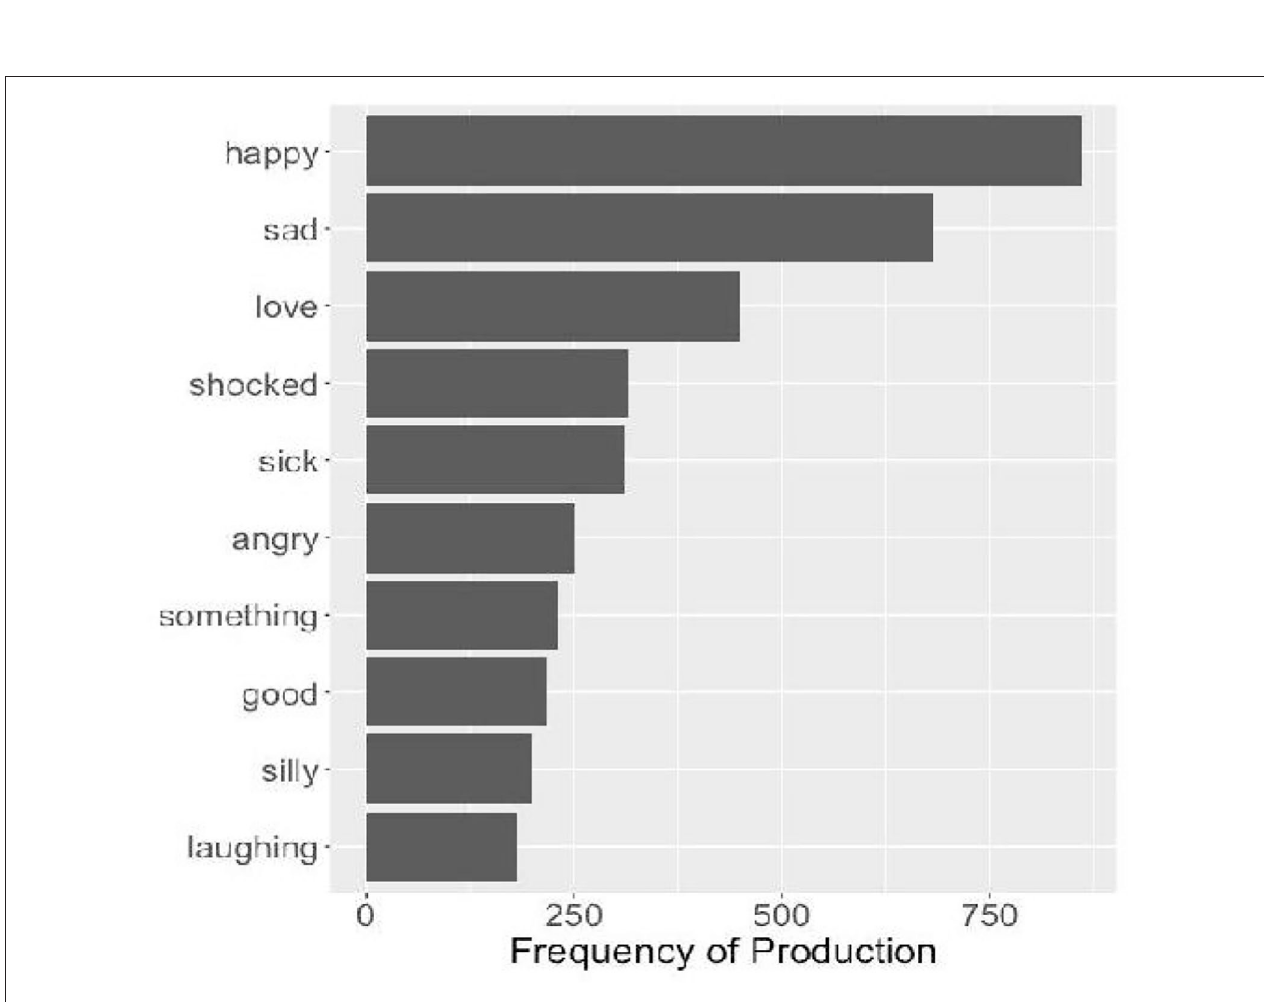
FIGURE 2 | The 20 most frequently produced individual words